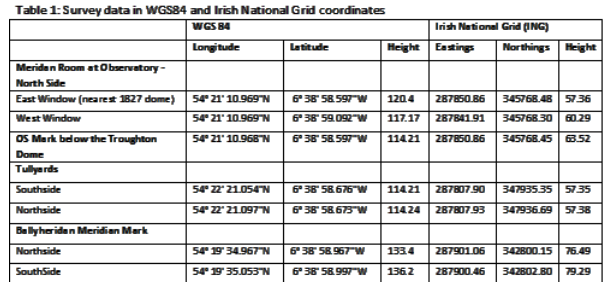
Table 1: Survey data in WGS84 and Irish National Grid coordinates